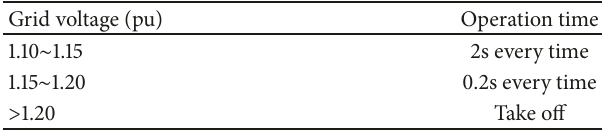
Table 1: HVRT requirement of State Grid Corporation of China.